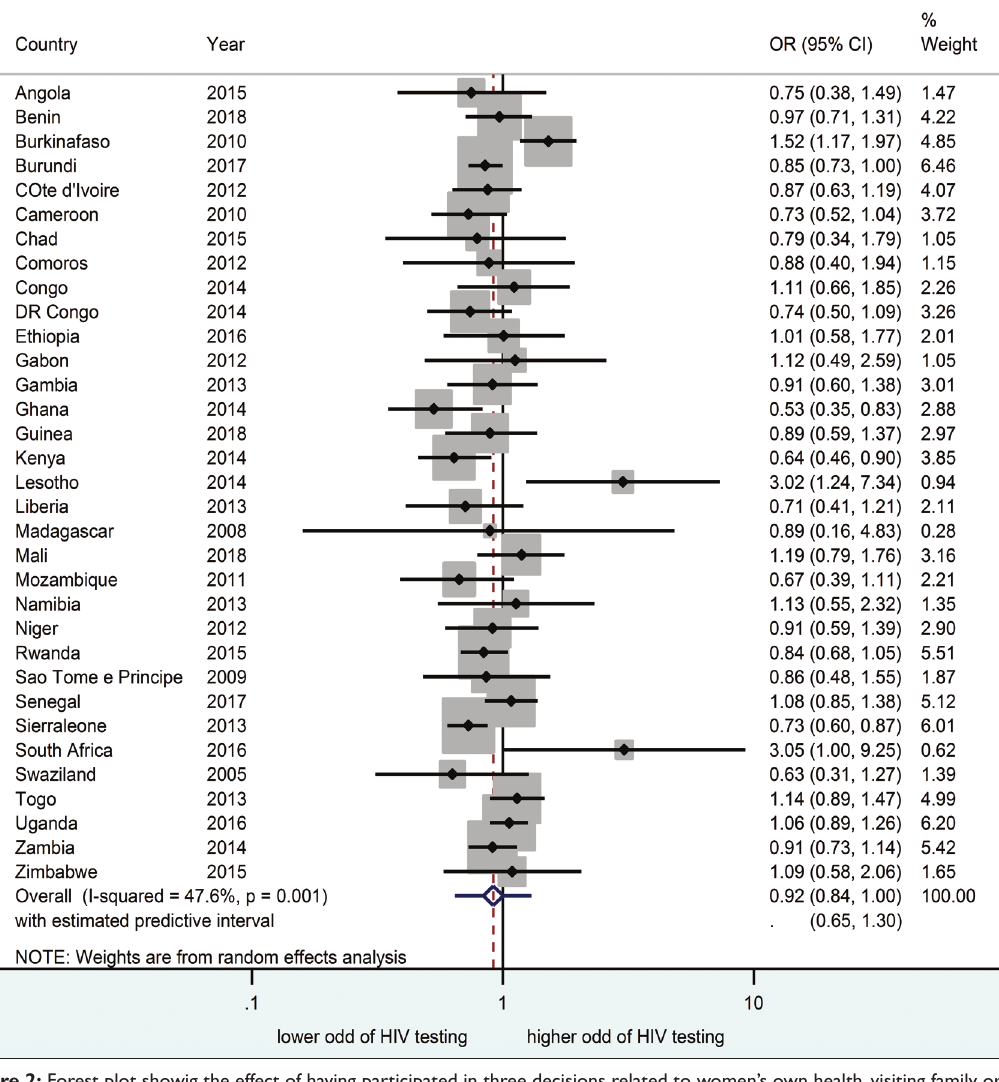
Figure 2: Forest plot showig the effect of having participated in three decisions related to women’s own health, visiting family or relatives and large household purchases on HIV